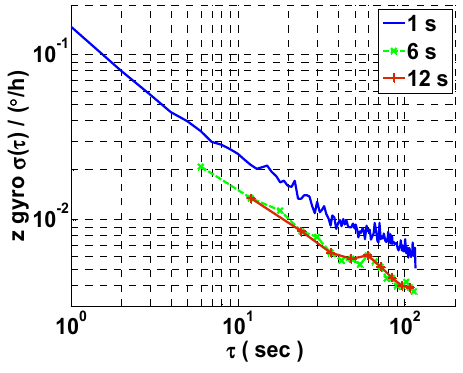
Figure 3. AVAR results of one measured data of z mechanically dithered RLG under stationary condition at different sample